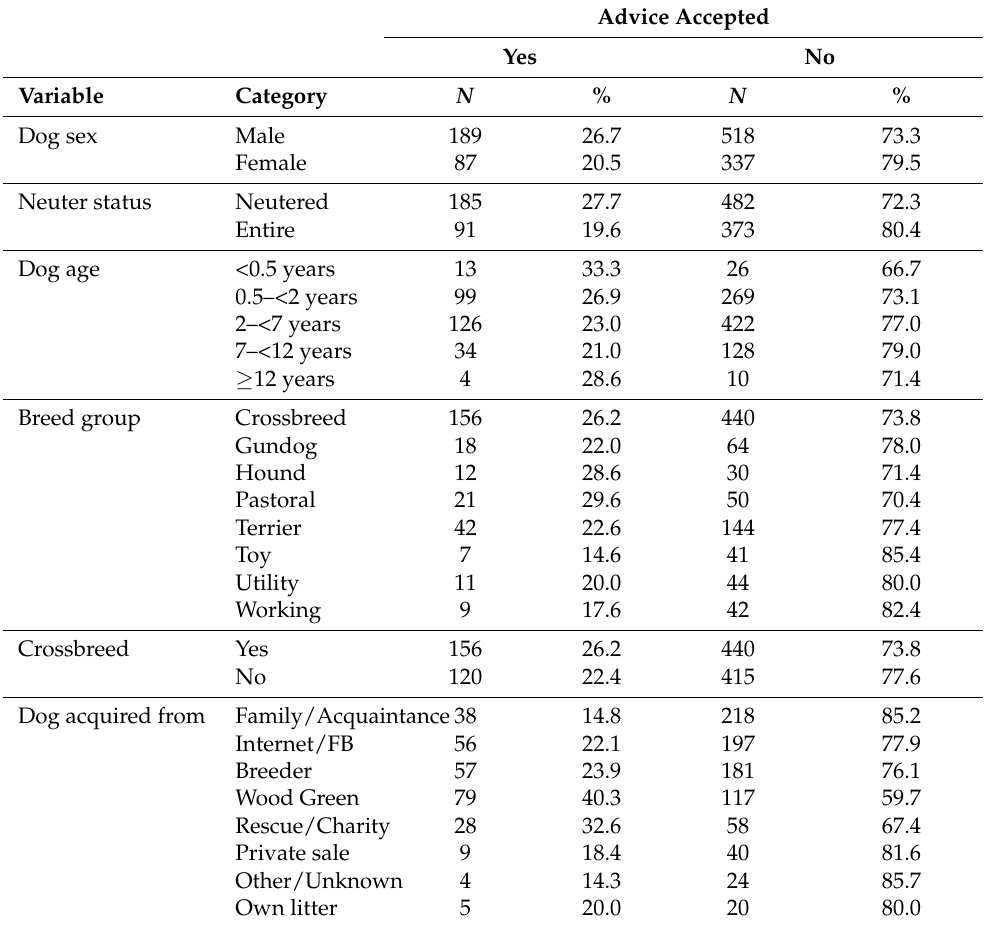
Table 2. Descriptive statistics for dog characteristics and whether advice was accepted or refused at the point of dog relinquishment request to Wood Green between January 2017 and August